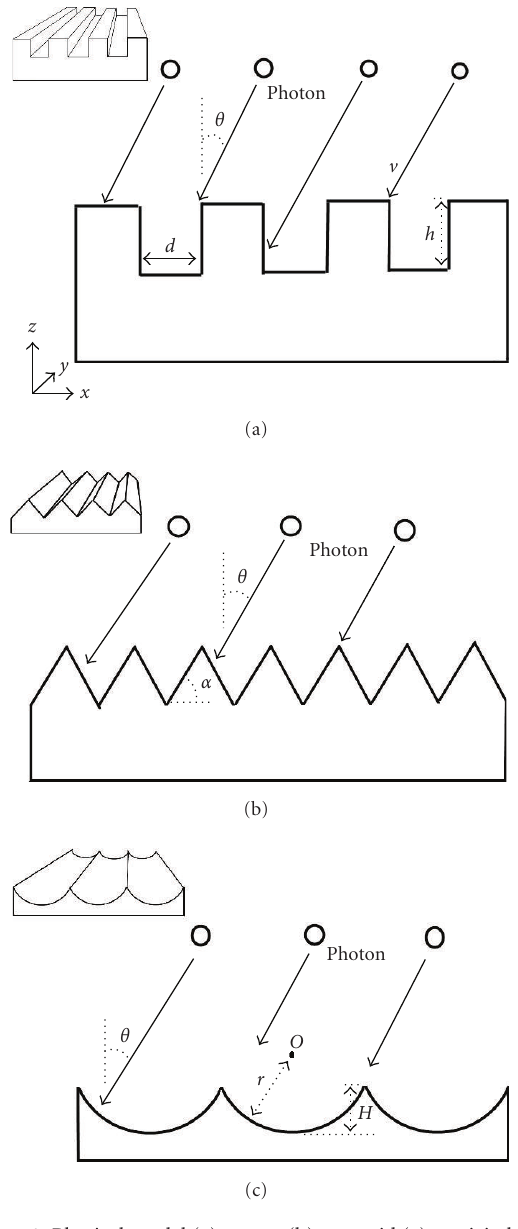
Figure 2: Physical model (a) square (b) pyramid (c) semicircle, the geometric variables are also shown in this figure.